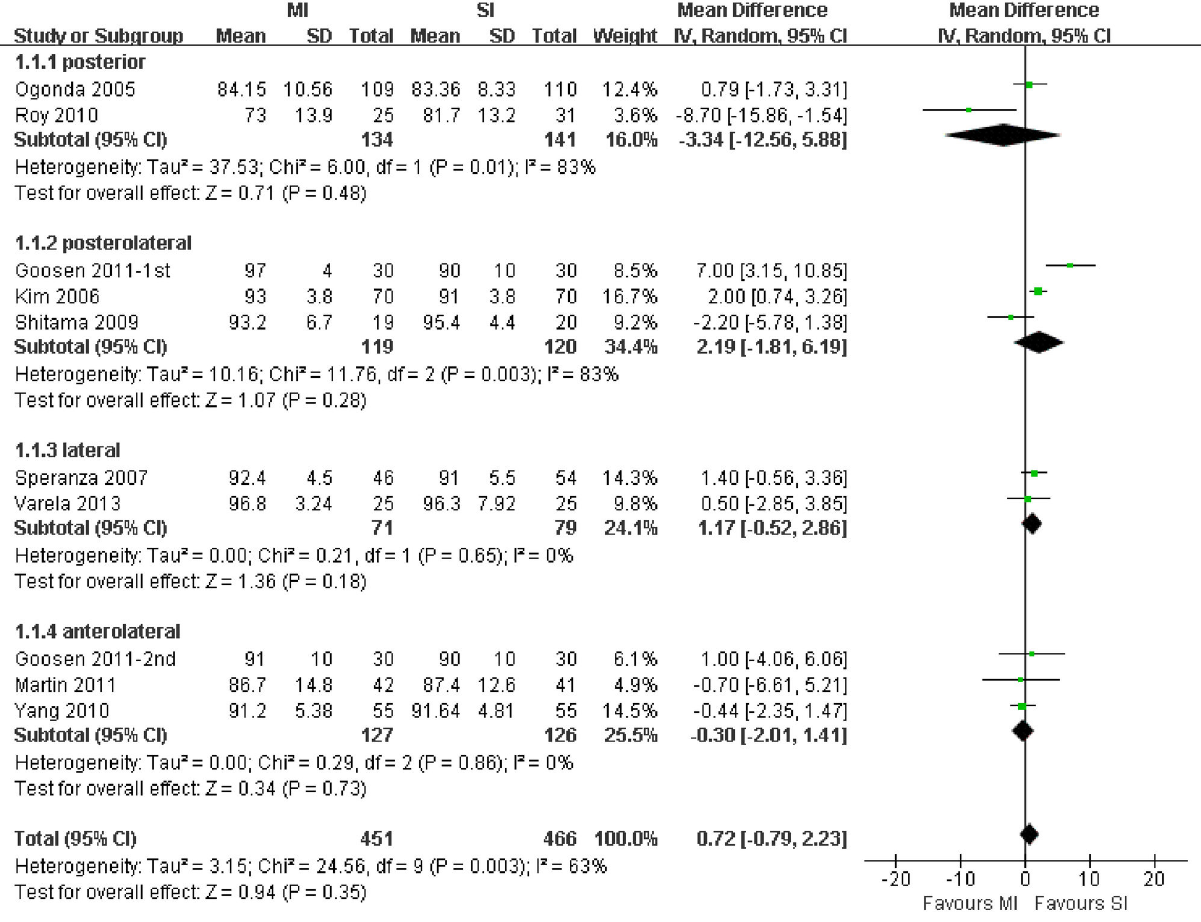
Figure 7. Meta-analysis of randomized controlled trials evaluating